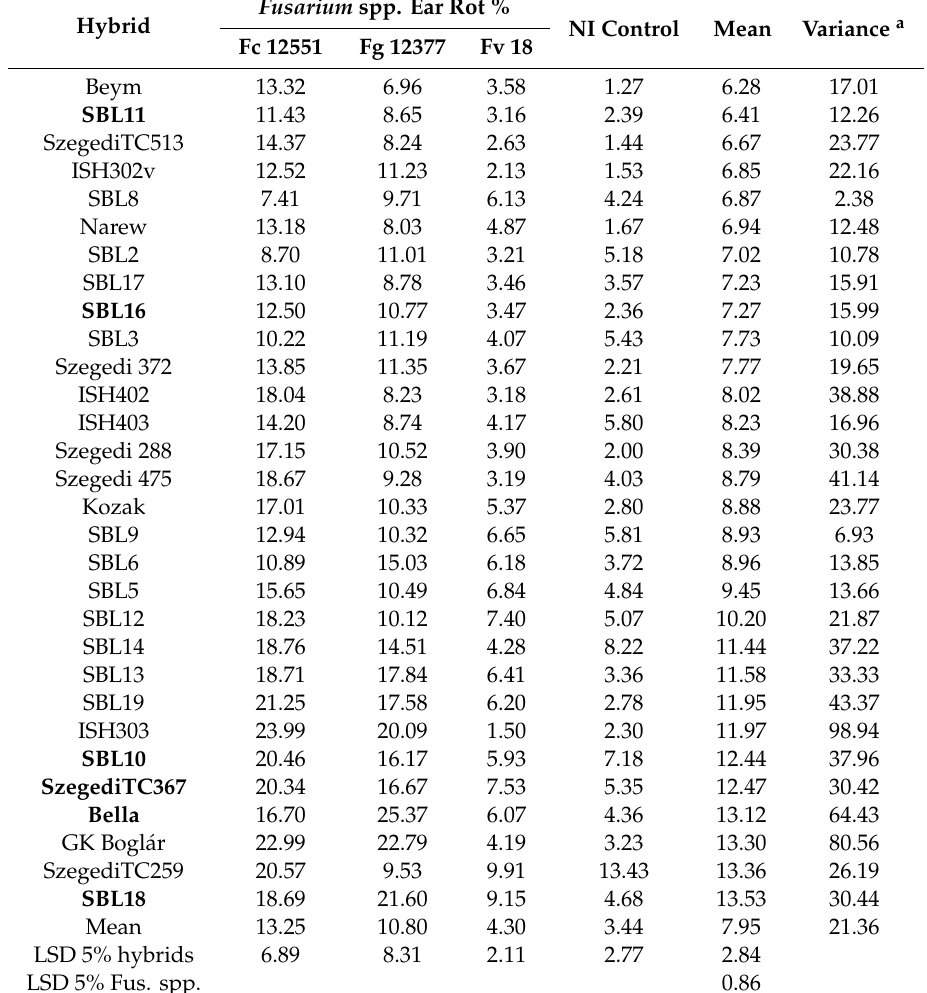
Table 2. Kernel resistance of maize hybrids to toxigenic fungi, correlations between resistance to them and the naturally infected control from data of Table 1. Toxigenic Fungi and Control Column Fc Fg NI Control